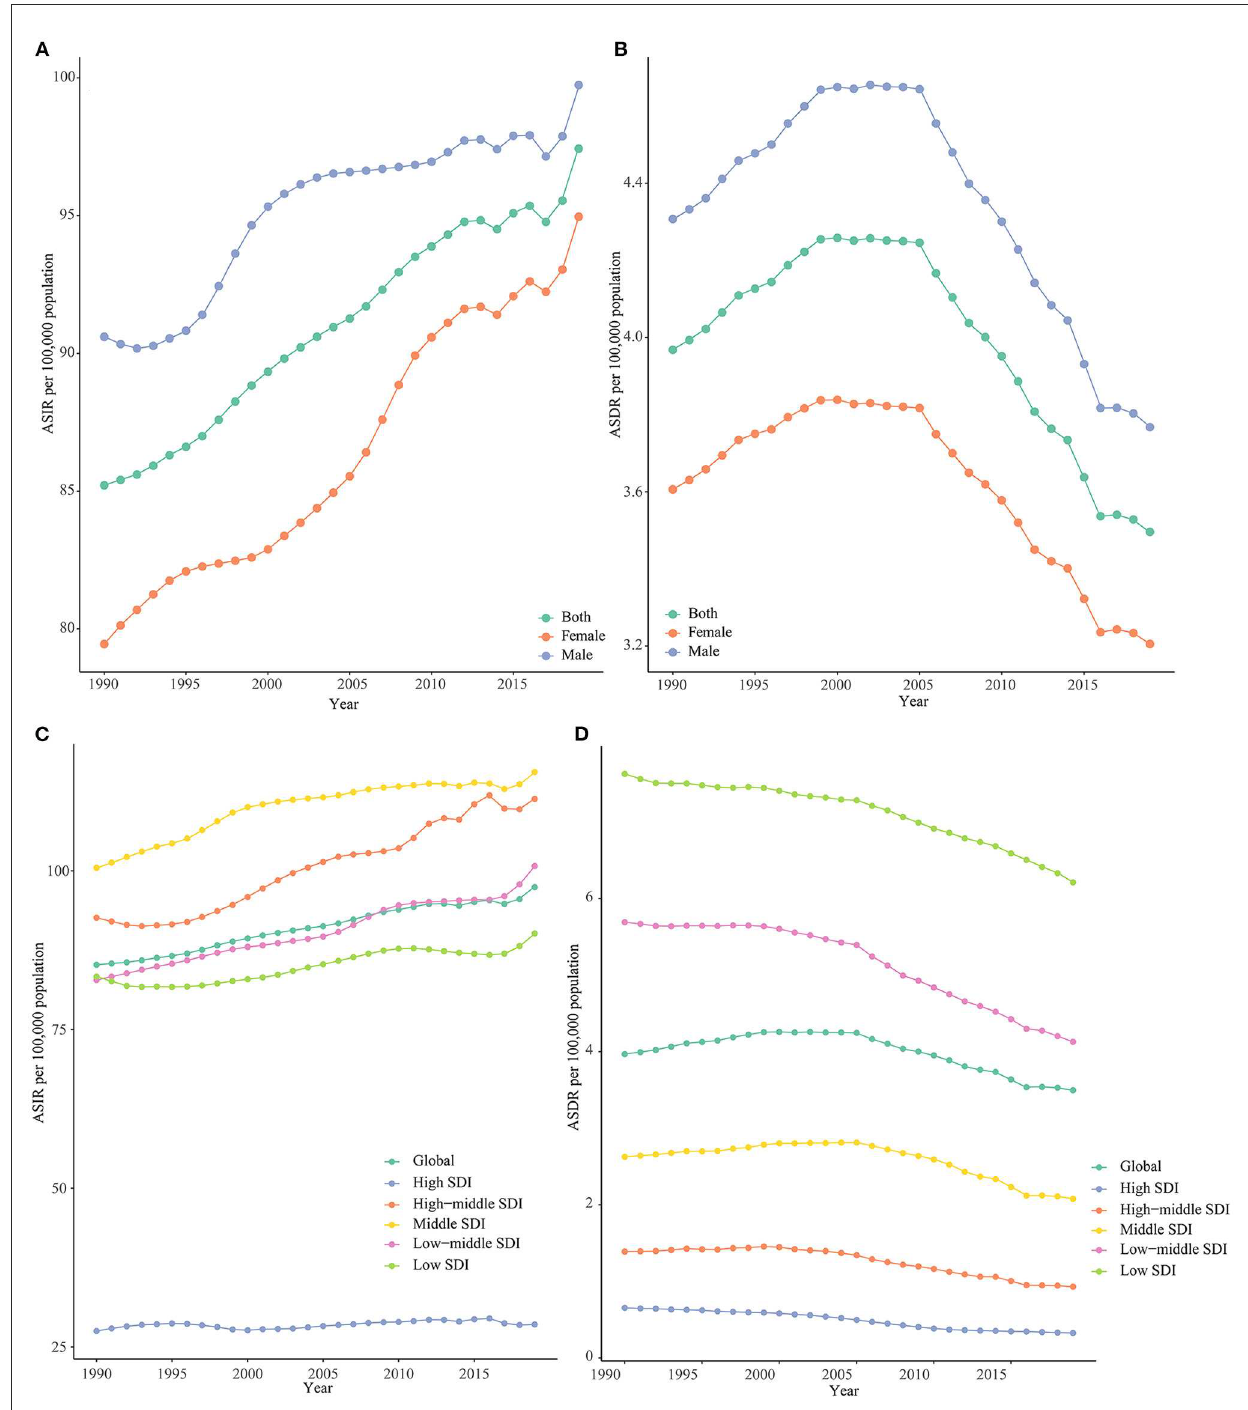
FIGURE1 Trends of global ASIRs (A) and ASDRs (B) by gender and global ASIRs (C) and ASDRs (D) by SDIs from 1990 to 2019.